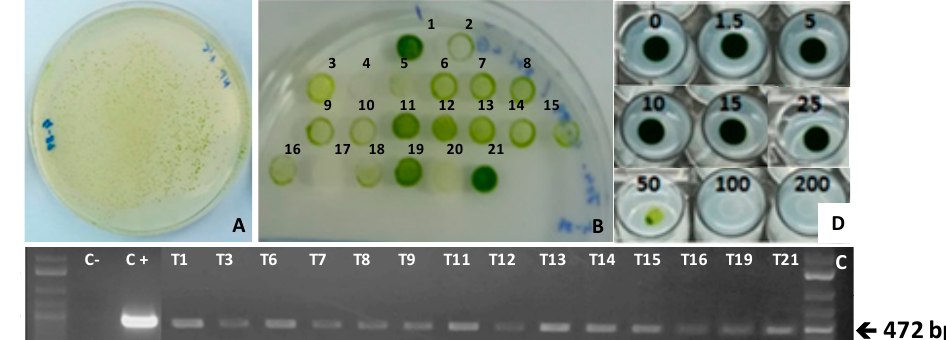
Figure 3. Molecular and phenotypic analysis of Norf R - Chlamydomonas transformants. Chlamydomonas transformants selected in TAP with 1.5 µ g mL − 1 of norflurazon ( A ) were cultured in TAP agar plates with 4 µ g mL − 1 of norflurazon for 10 days ( B ). A band of the expected size (472 bp) corresponding to the CRTIop amplicon was shown in all the transformants tested ( C ). A norflurazon sensitivity test for the selected transformant T21 ( D ) was carried out as described in the Figure 2 legend with the indicated concentrations of norflurazon (from 0 to 200 µ g mL − 1 ).